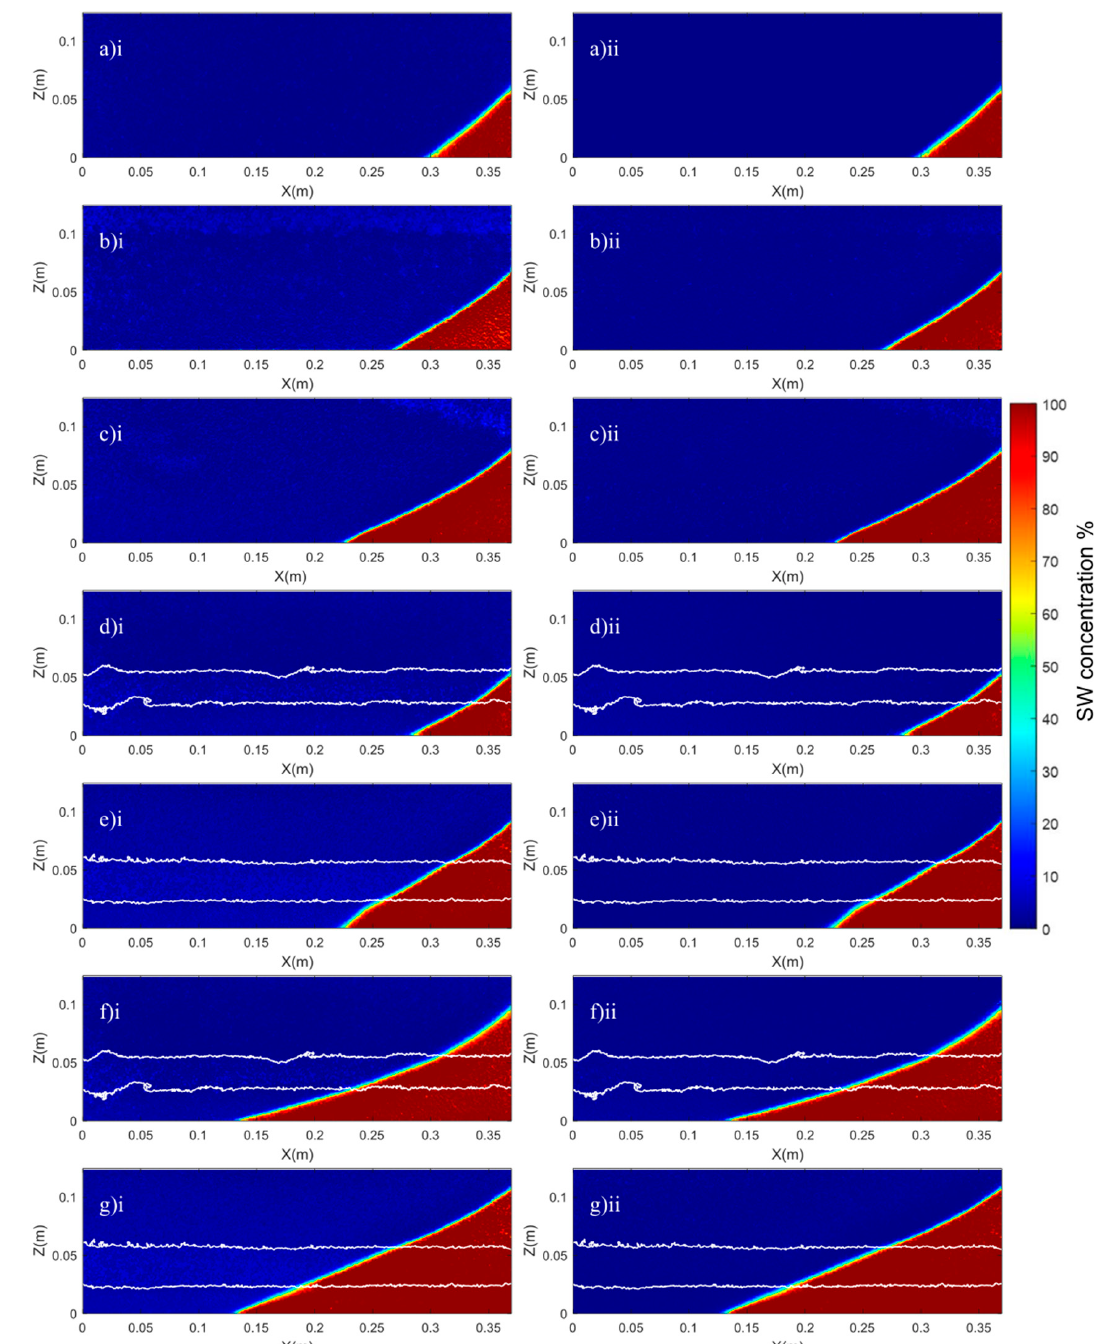
Figure 11. Steady state saltwater concentration fields of the ( a ) 780 µm, ( b ) 1090 µm, and ( c ) 1325 µm, homogeneous, and the ( d ) Layered1 and ( e ) Layered2 heterogeneous aquifers. Transient state SW concentration fields of the ( f ) Layered1 and ( g ) Layered2 heterogeneous aquifers generated by (i) pixel wise regression (left) and by (ii) the proposed ML technique (right).